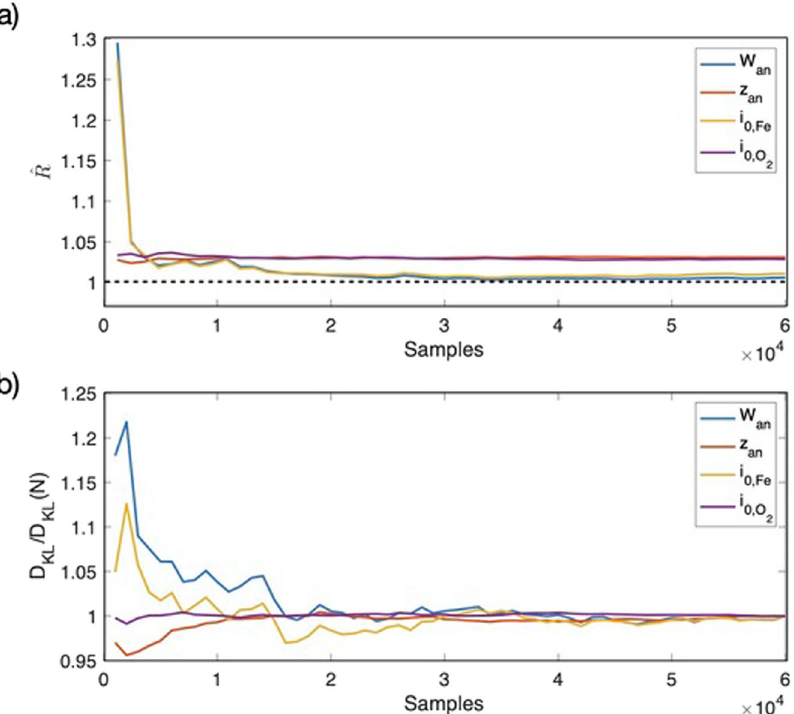
Fig. 5 Convergence assessment of the Markov-chains. a The evolution of ^ R ð k Þ over the samples for the four different model parameters. b The evolution of the information gain (Kullback − Leibler divergence) D KL over the samples, normalized versus the divergence at N = 60,000 samples. In around 30,000 samples ^ R ð k Þ has approached 1 and the information gain is stable, suggesting the Markov chains have converged and the posterior is suf fi ciently